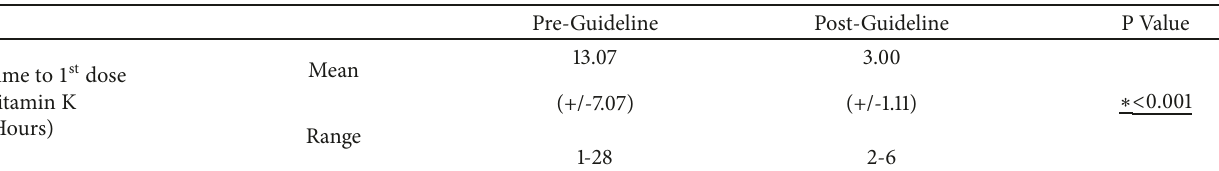
Table 2: A comparison of pre- and post-guideline time to first dose of 2mg intravenous vitamin K from admission. Pre-Guideline